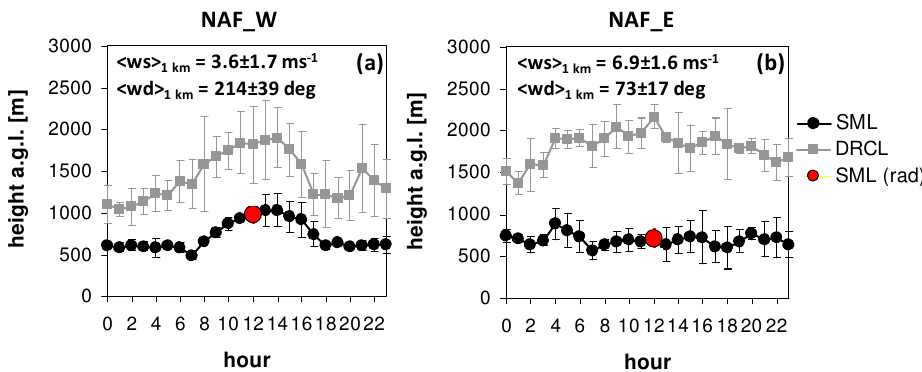
Fig. 3. Mean SML (black dotted line) and DRCL (grey dotted line) diurnal cycles from ceilometer and SML heights from radiosoundings retrieved at 12:00UTC (red dot) averaged during the NAF W days (Fig. 3a) and the NAF E days (Fig. 3b). Error bars represent one standard deviation of the means. < ws > 1 km and < wd > 1 km stand for mean wind speed and direction, respectively, averaged within the first kilometre of height from radiosoundings.